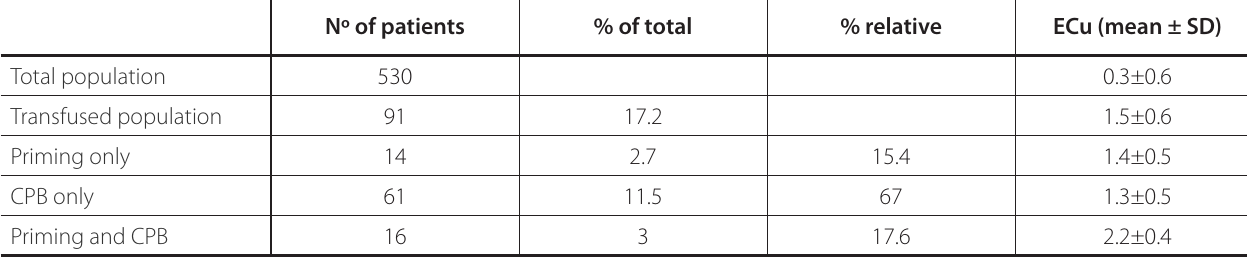
Table 2 . Data related to erythrocyte concentrate transfusion in the study